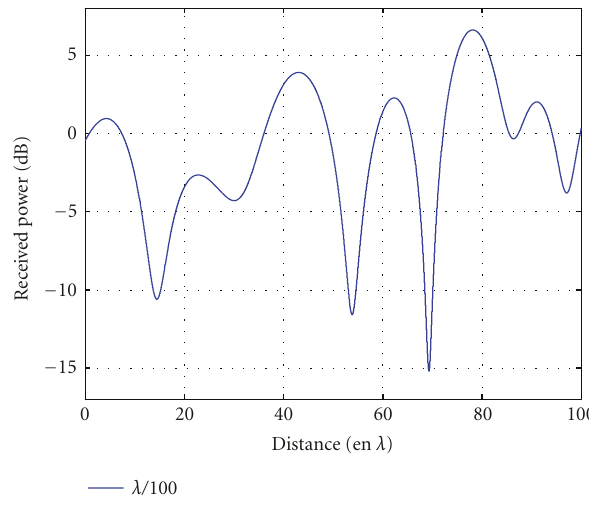
Figure 5: Fading generated from a 10 ◦ azimuth distribution.